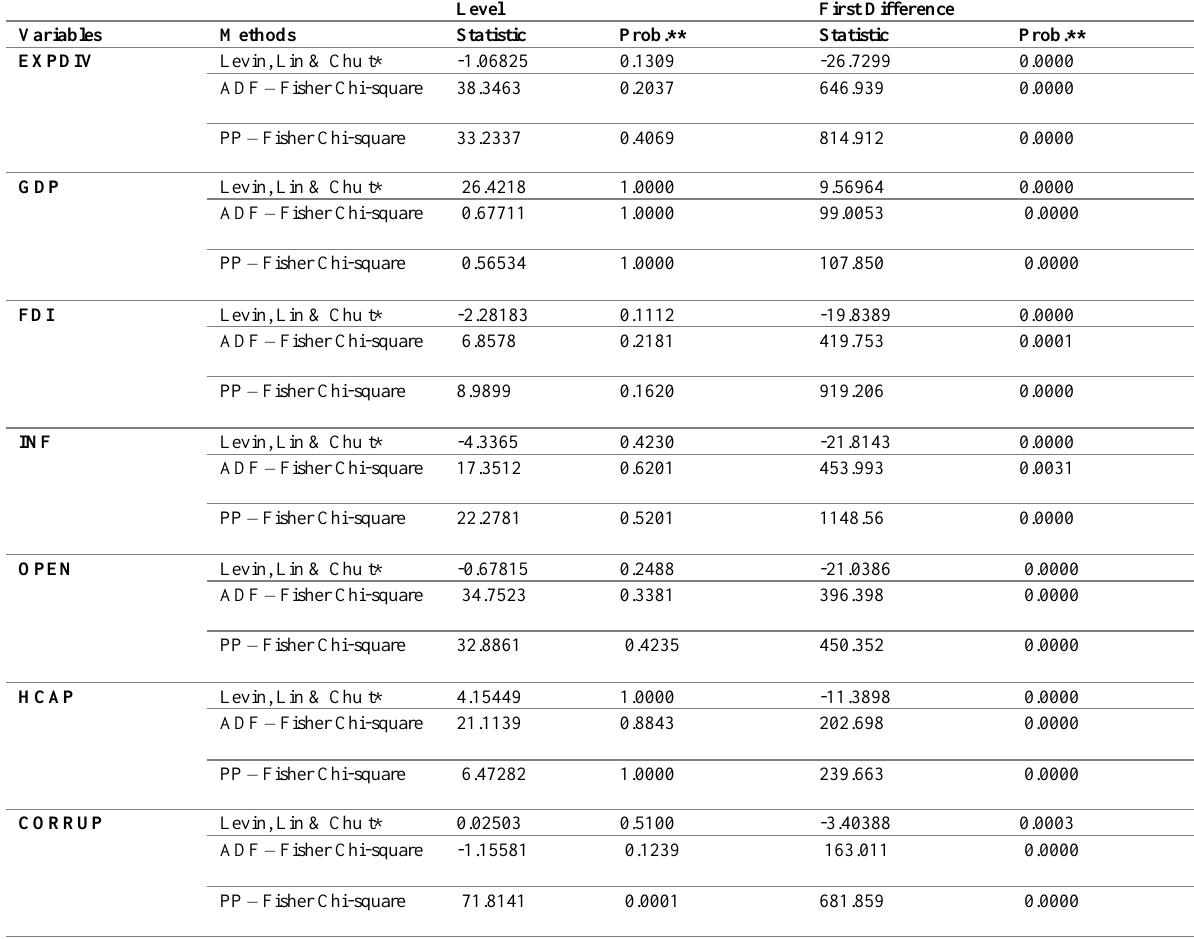
Table 1 : Panel Unit-Root Test